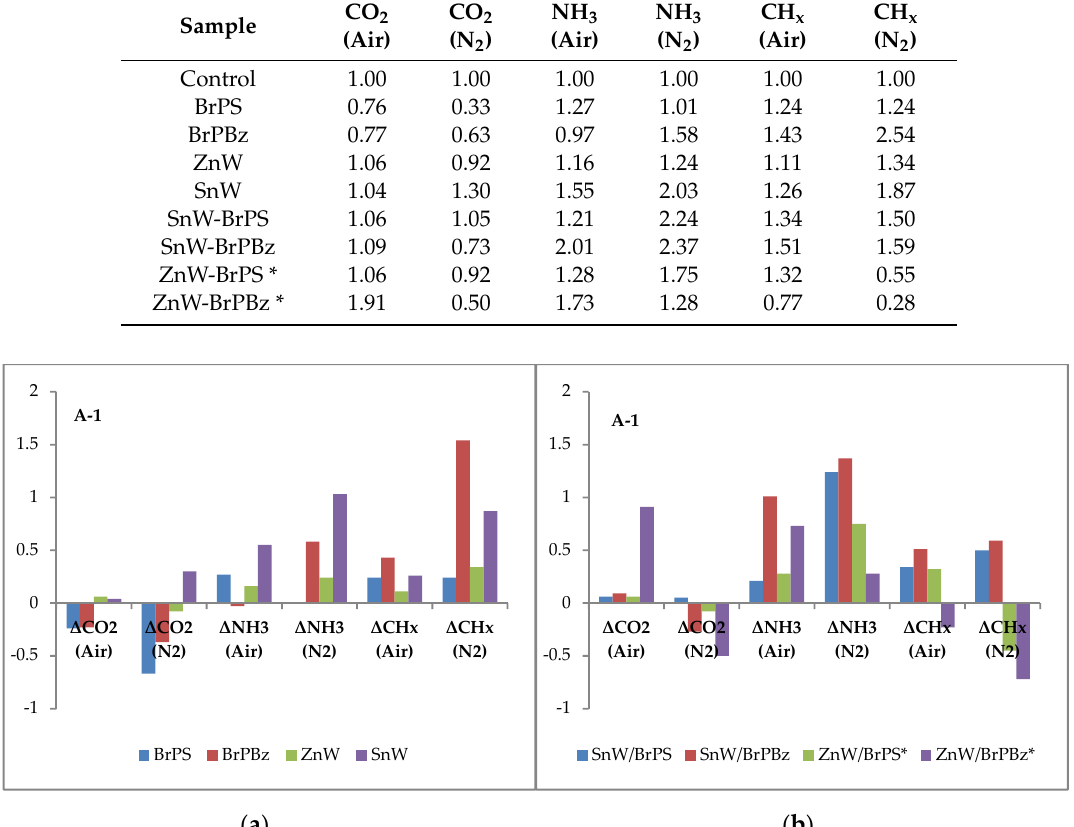
Figure 7. Variations in TGA-FTIR production of CO 2 , NH 3 , and CH x by the samples listed in Table 3 relative to pure PA66 and plotted as (A-1.00, see Table 3) ( a ) BrPS, BrPBz, ZnW and SnW controls, ( b ) combinations of ZnW and SnW with BrPS and BrPBz in PA66. Negative values represent a reduction in gas / volatile production, while positive values represent increases relative to the control. BrPS = brominated polystyrene; BrPBz = poly(pentabromobenzyl acrylate); SnW and ZnW = tin (II) and zinc tungstates respectively.